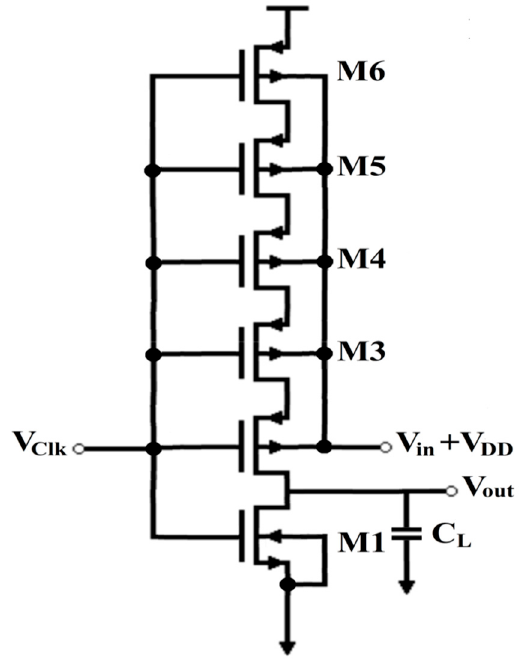
Figure 7. Final architecture of the second proposed VTC circuit.